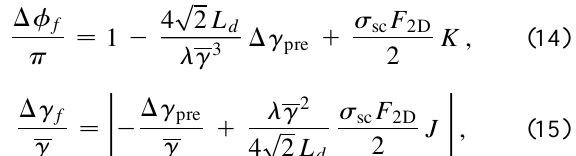
FIG. 3. Geometric factors in coupling between beam optics and space charge. J is the energy spread, and K is the phase spread. All examples have ´ N (cid:1) 1 mm mrad, g (cid:1) 88 , L d (cid:1) 2 m, and z w 1 (cid:1) 2 0.235